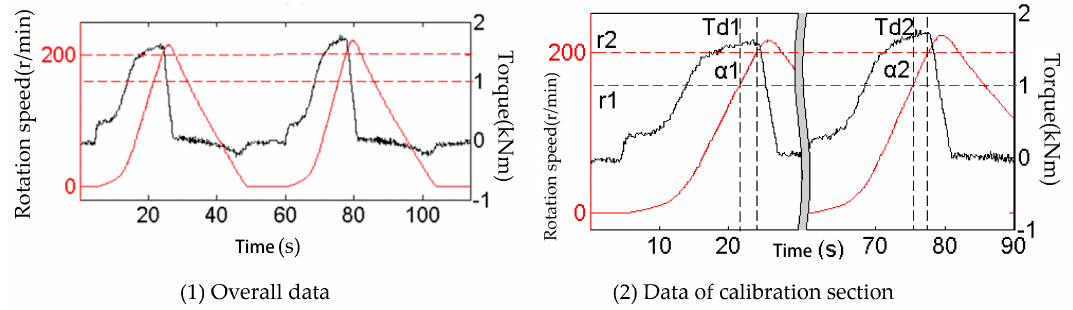
Figure 21. Test results of basic inertia calibration.